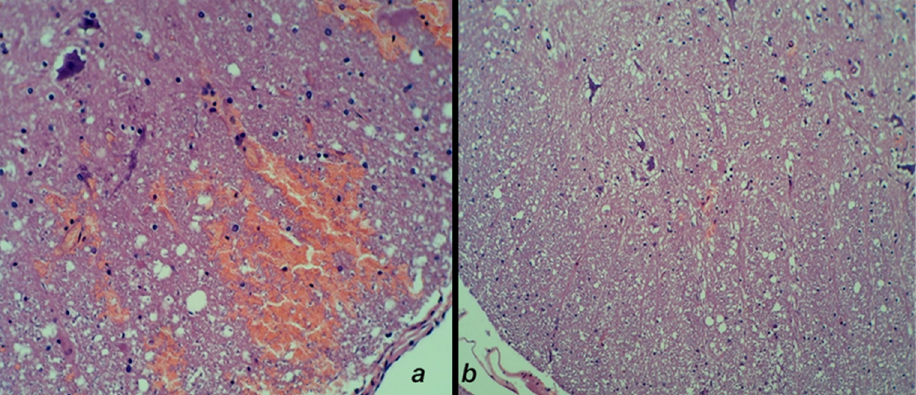
Figure 11. Post-injury time of 30 min-. Neuropathological changes in the posttraumatic spinal cord at the lesion site after 20 min following medication, which was applied at 10 min post-injury time. ( a ) The control group edema and massive hemorrhage in the area of the intermediate grey matter and the lateral and posterior white columns. ( b ) BPC 157 rats with minimal edema and hemorrhage (HE staining; magnification 100×).